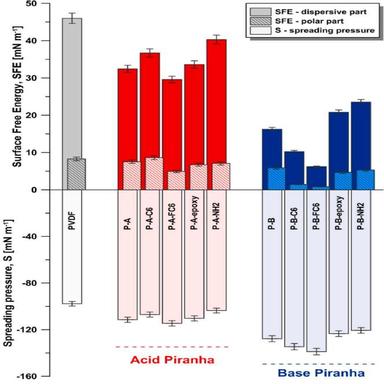
Wetting – SFE and spreading pressure.